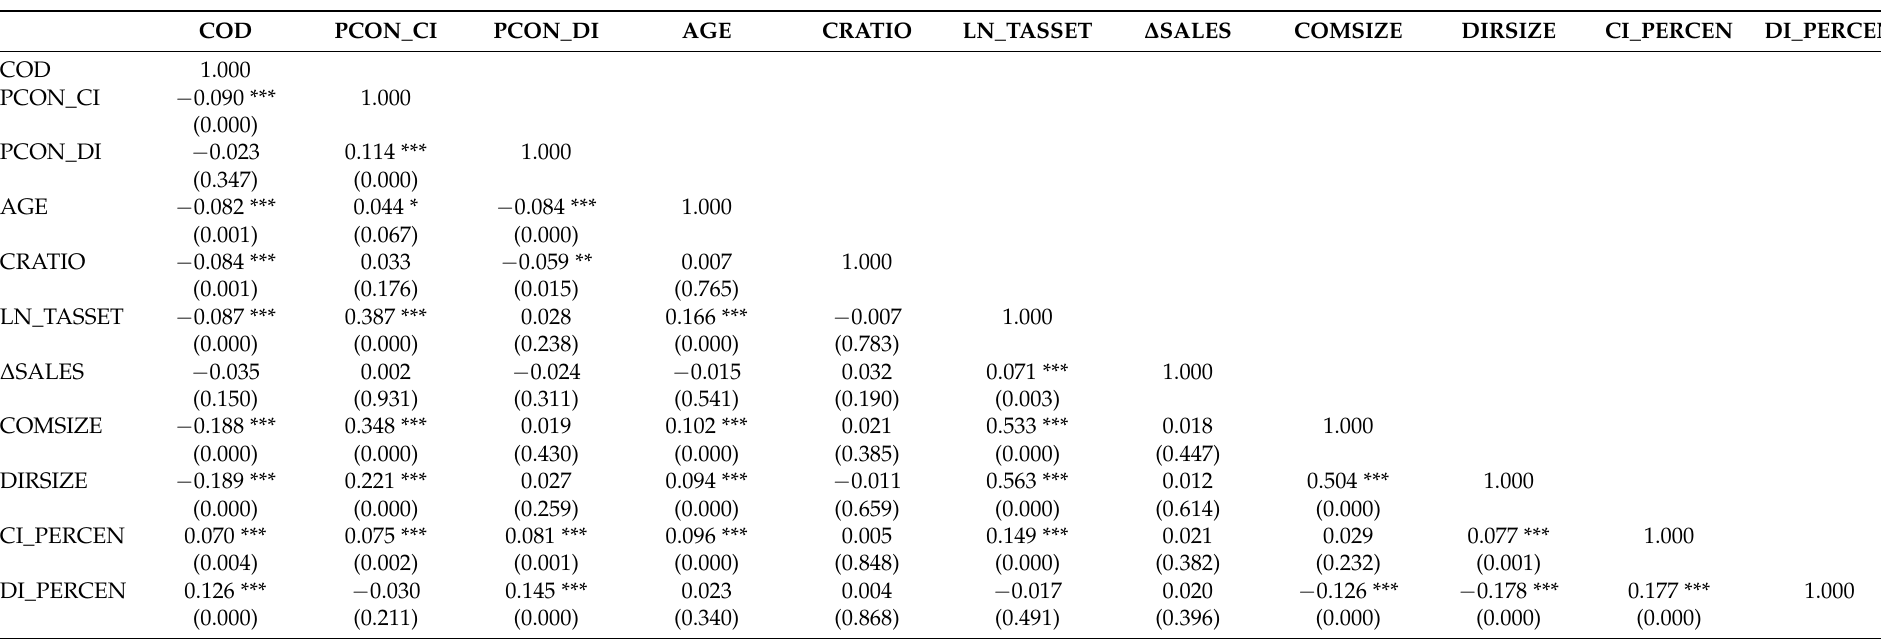
Table 5. Pearson Correlation between Politically Connected Independent Commissioners and Independent Directors on The Cost of